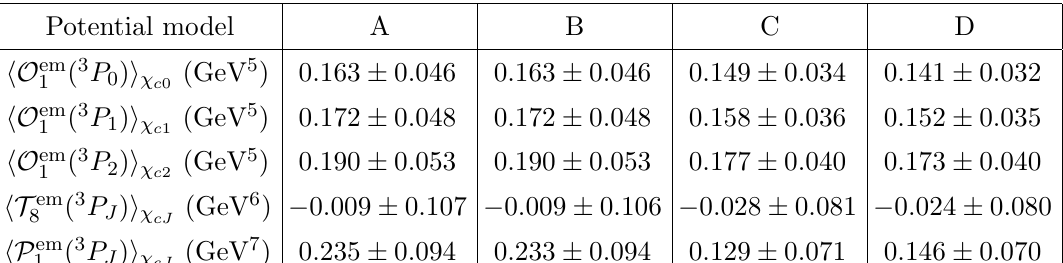
( 3 P J ) j (cid:31) cJ (1 P ) i ( hO em 1 ( 3 P J ) i (cid:31) for short) and h (cid:31) cJ (1 P ) jP em 8 cJ